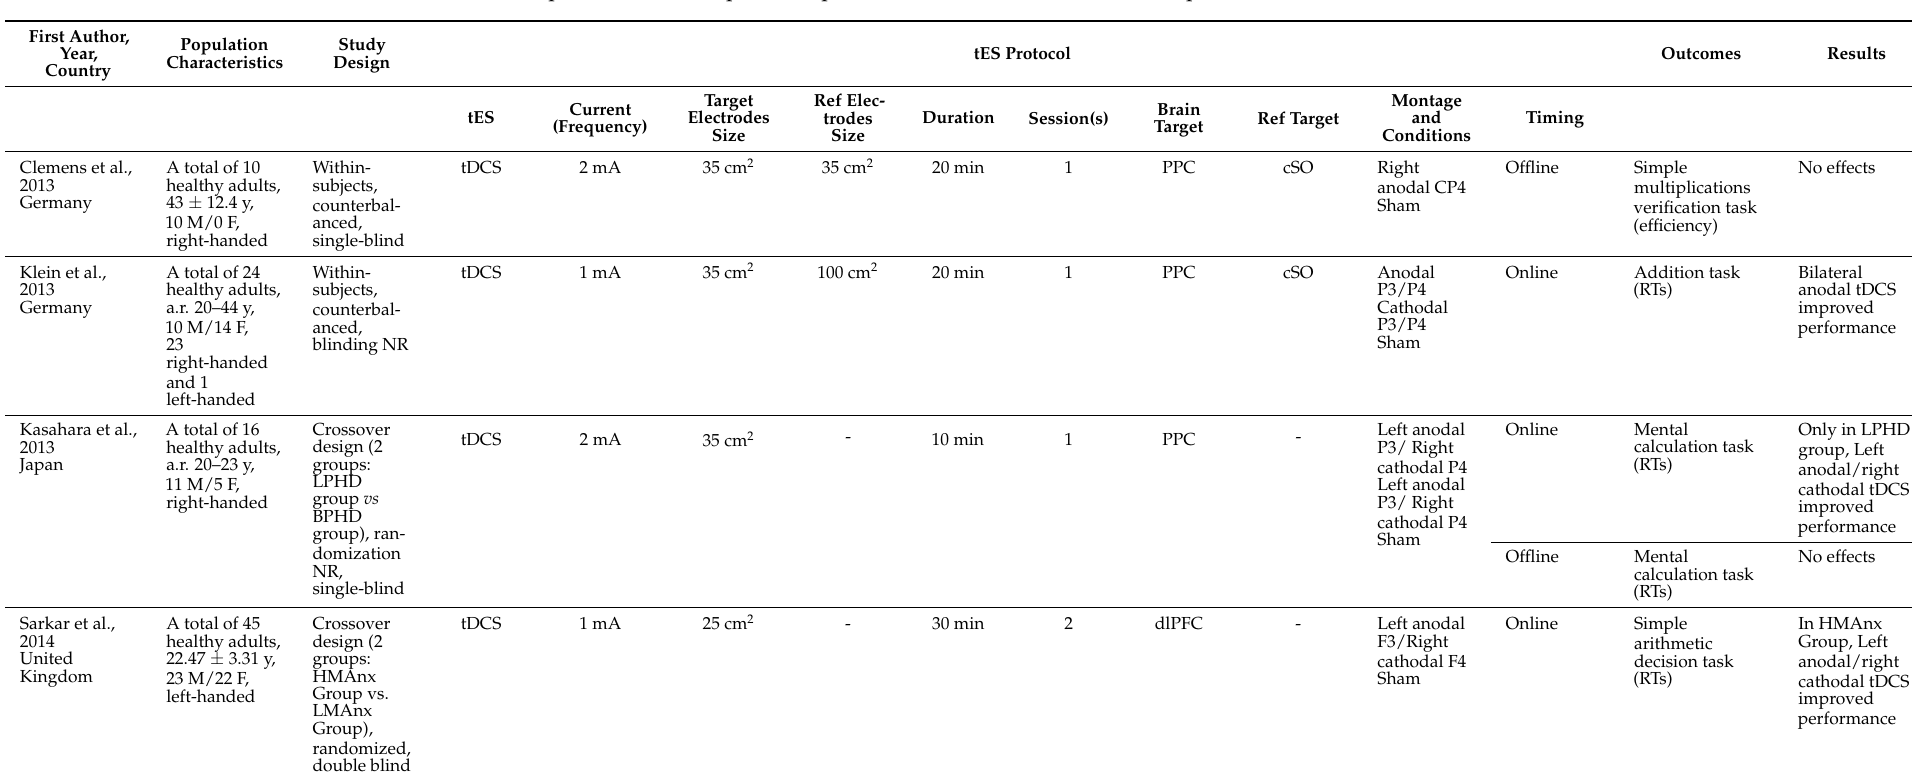
Table 2. Summary of results for arithmetic processes and characteristics of the reviewed tES studies according to the population, intervention, comparison, outcomes and study design (PICOS) approach. Studies are presented in order of citation in the text, Section 3.4. Legend: a.r. = age range, M/F = male/females, y = years, NR = not reported, Exp. = experiment, tDCS = transcranial direct current stimulation, tRNS = transcranial random noise stimulation, tACS = transcranial alternating current stimulation, mA = milliampere, Hz = hertz, Ref = Reference, A = anodal, C = cathodal, cm 2 = square centimeters, min = minutes, s =